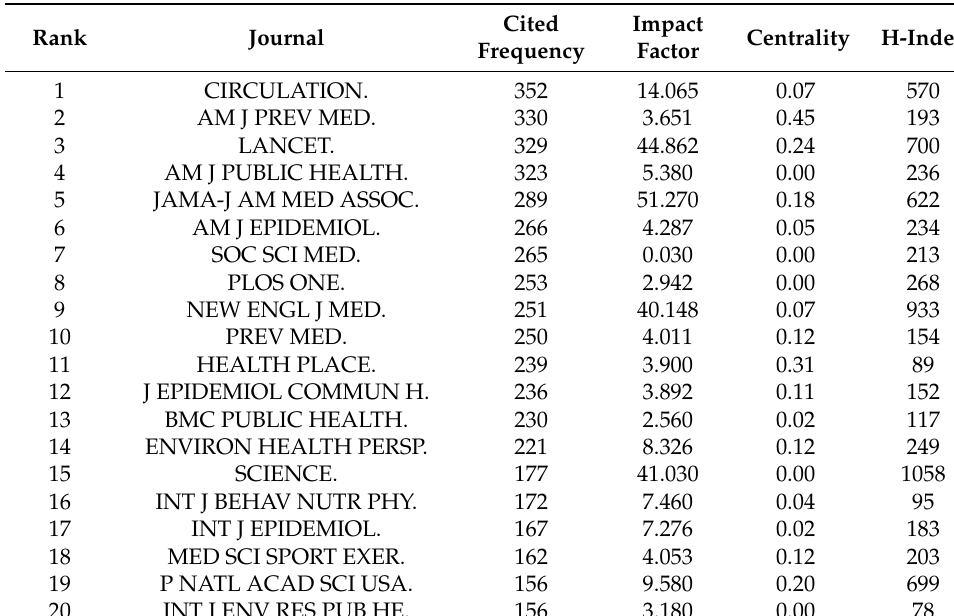
Figure 3. Knowledge map of co-citation journals network. Table 1. The top 20